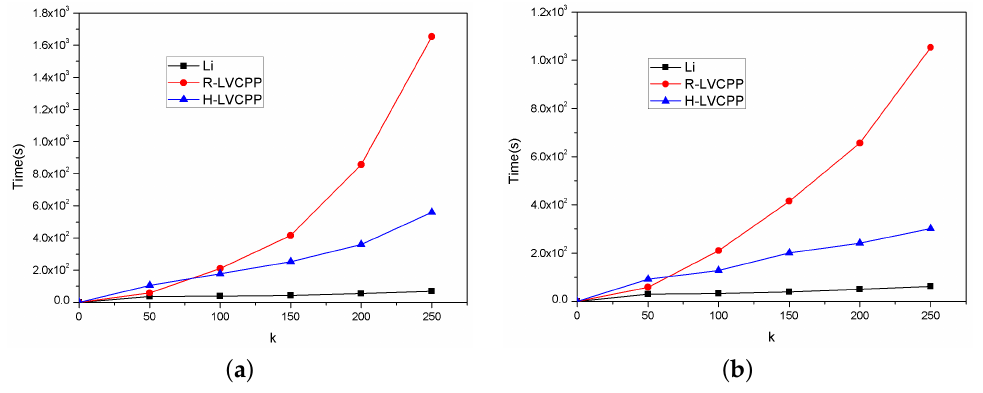
Figure 4. Runtime varies with parameter k : ( a ) Brightkite; ( b ) Gowalla.